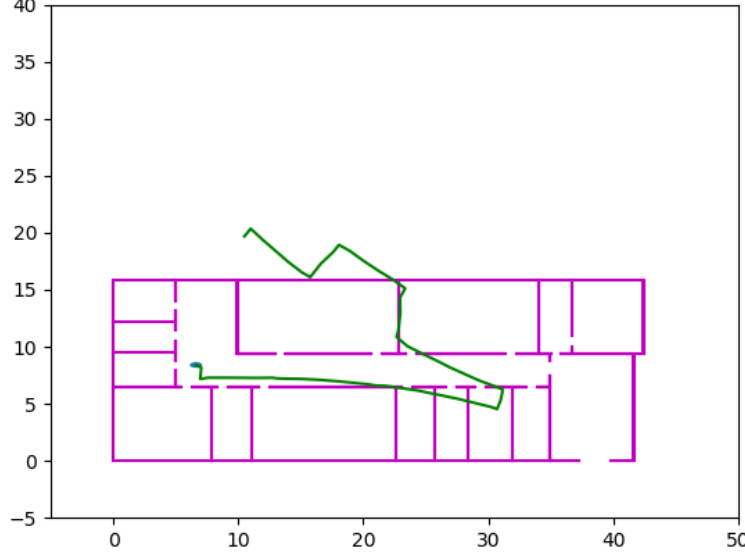
Figure 5. Estimation of an agent’s path without any map matching algorithm. The axes are defined in meters